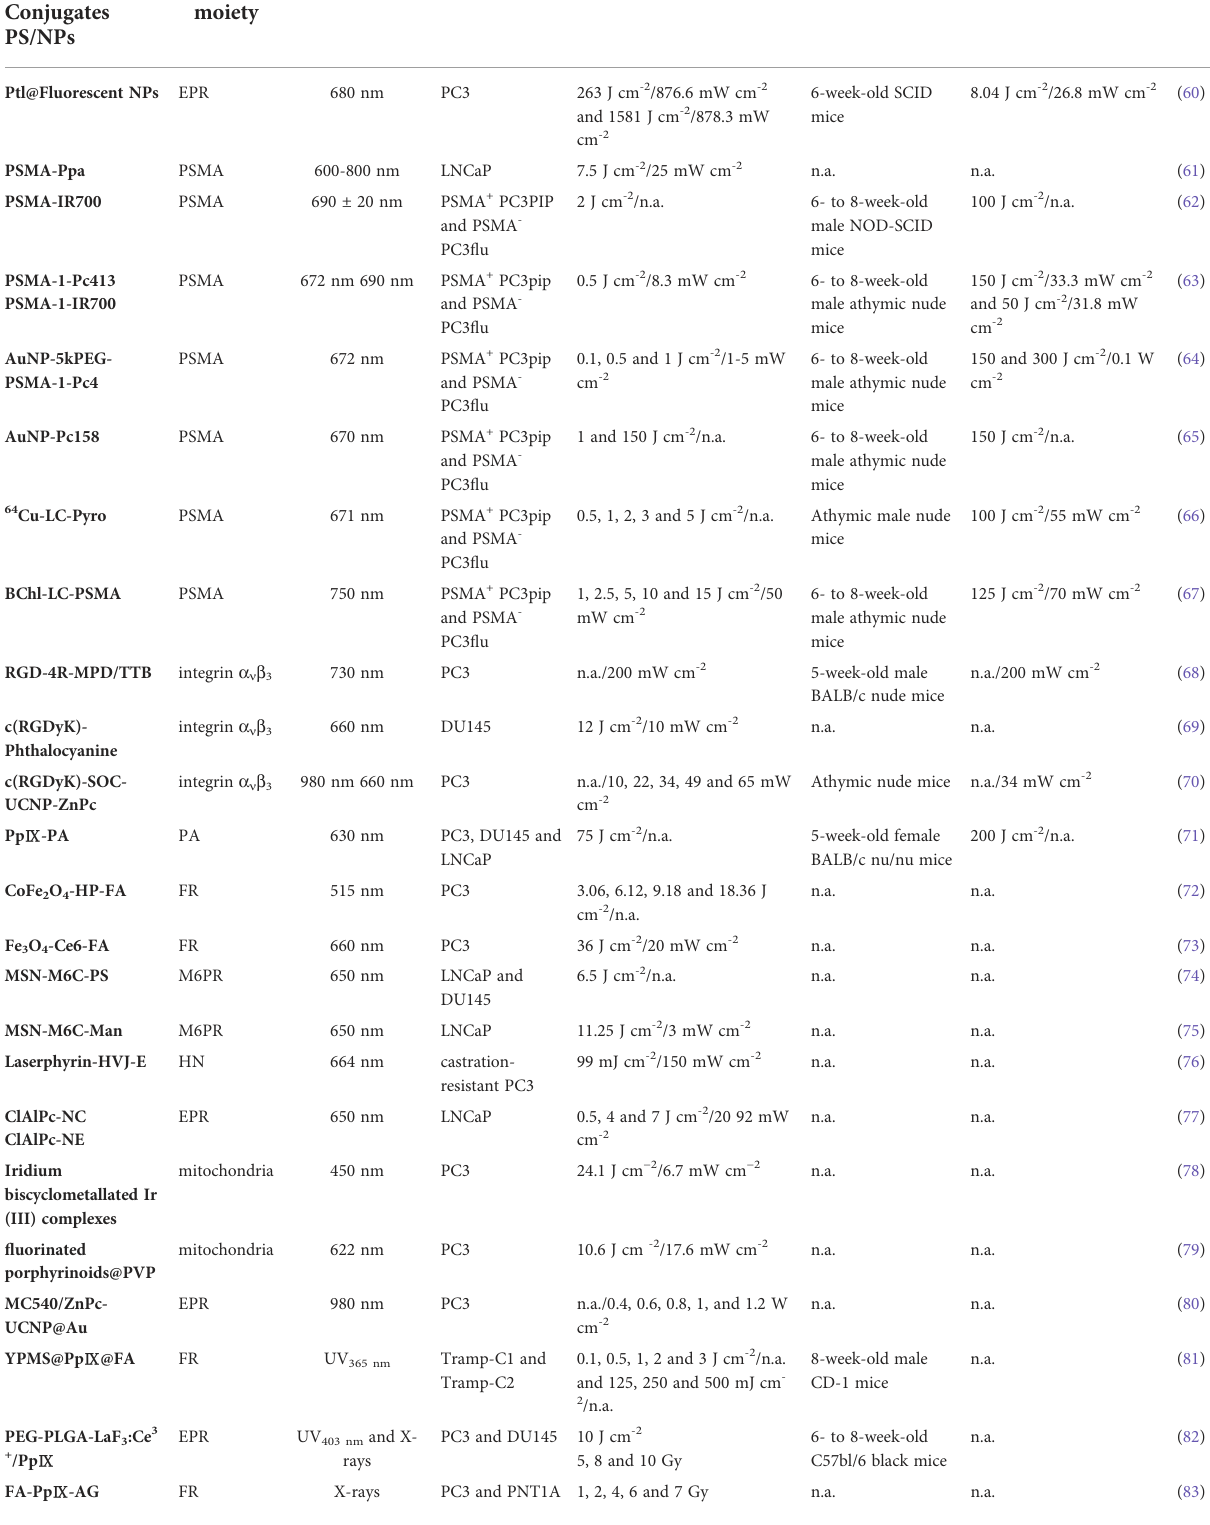
TABLE 4 Different preclinical studies of PDT for prostate